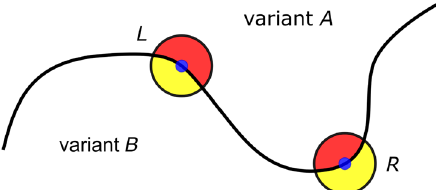
FIG. 3. The surface tension effect at domain boundaries. Blue dots represent speakers and black circles give an approximate representation of interaction ranges. In the red shaded parts of these interaction ranges, variant A is more common, and in the yellow shaded parts, variant B is more